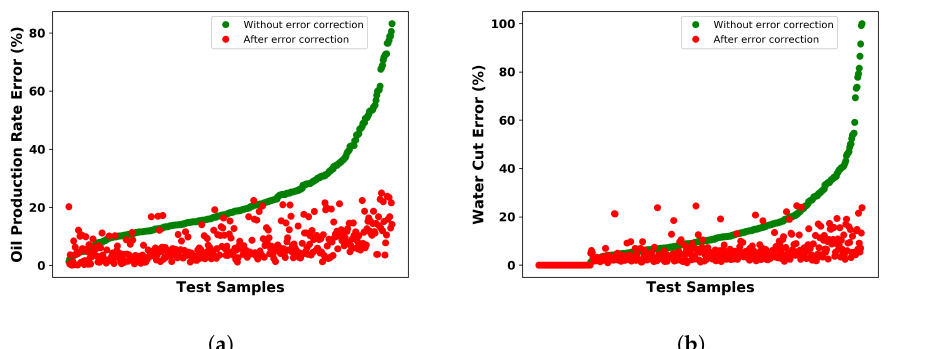
Figure 43. Error in the prediction of ( a ) the oil production rate ( b ) water cut for all the test cases before and after the error correction of the